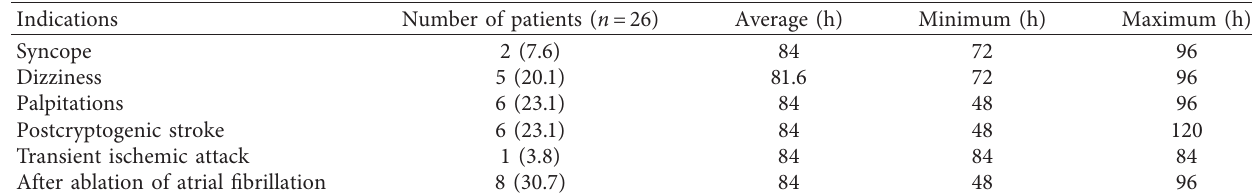
Table 2: Indications and wear time.